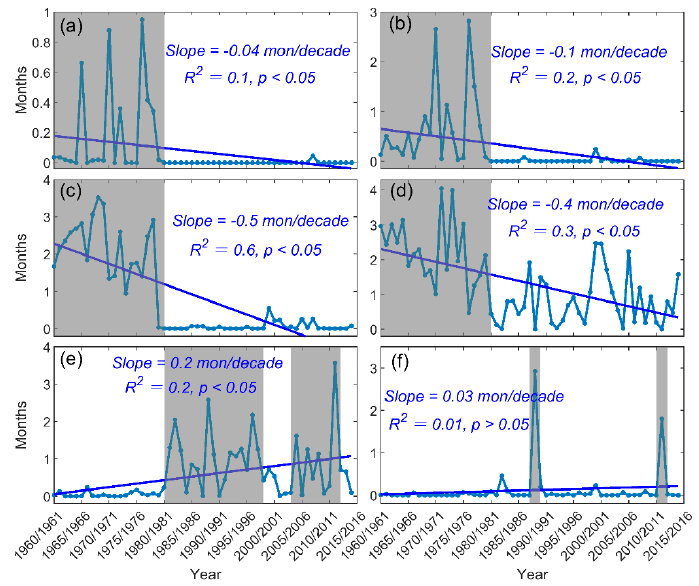
Figure 8. Changes in frequency of drought and wetness events of different magnitudes in SRYRB during 1960–2015 on the vegetation growing seasonal (VGS) scale. ( a ) Extreme drought, ( b ) severe drought, ( c ) moderate drought, ( d ) mild drought, ( e ) moderate wetness and ( f ) severe and extreme wetness.